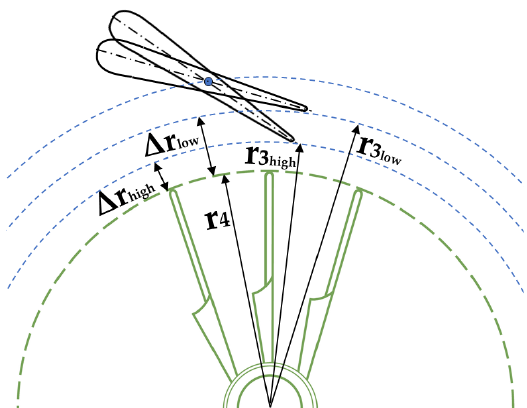
Figure 4. Radial gap between nozzle outlet section (radius r 3 ) and rotor inlet section (radius r 4